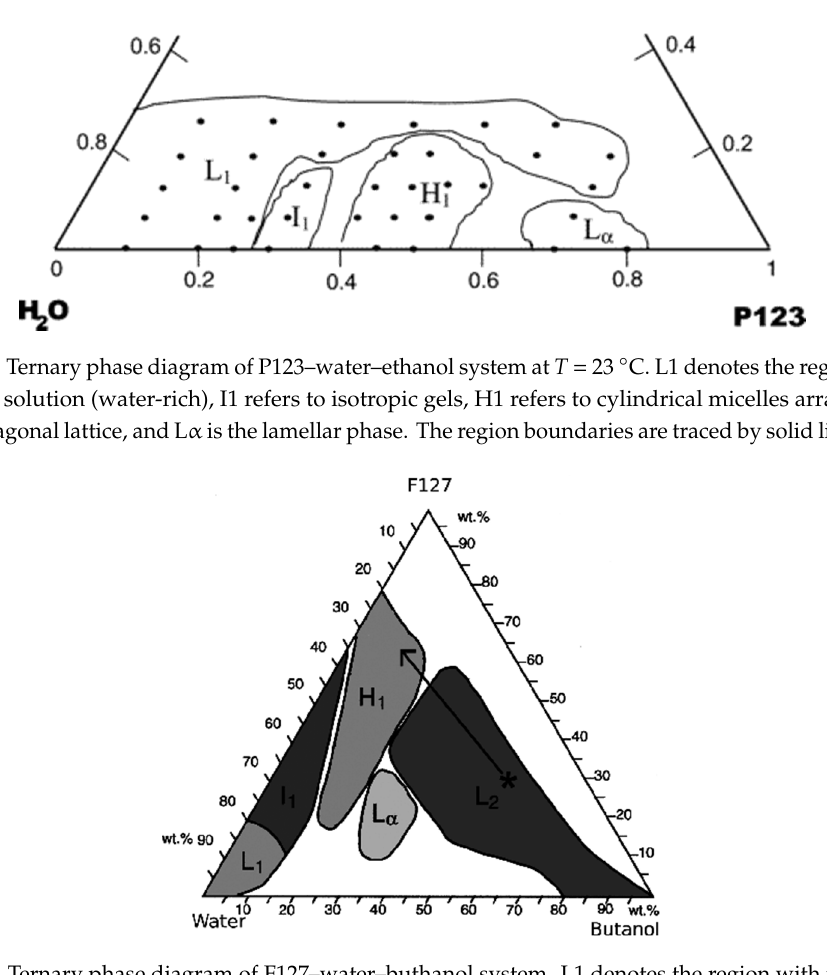
Figure 5. Ternary phase diagram of F127–water–buthanol system. L1 denotes the region with isotropic solution (water-rich), I1 refers to isotropic gels, H1 refers to cylindrical micelles arranged in a 2D hexagonal lattice, L α is the lamellar phase, and L2 is a reverse isotropic micellar phase. The region boundaries are traced by solid lines. The arrow indicates the delicate balance of these regions: for example, the rapid evaporation of solvent may occur during some processes, such as spin-coating, thereby producing a transition from lamellar to hexagonal phase [38].